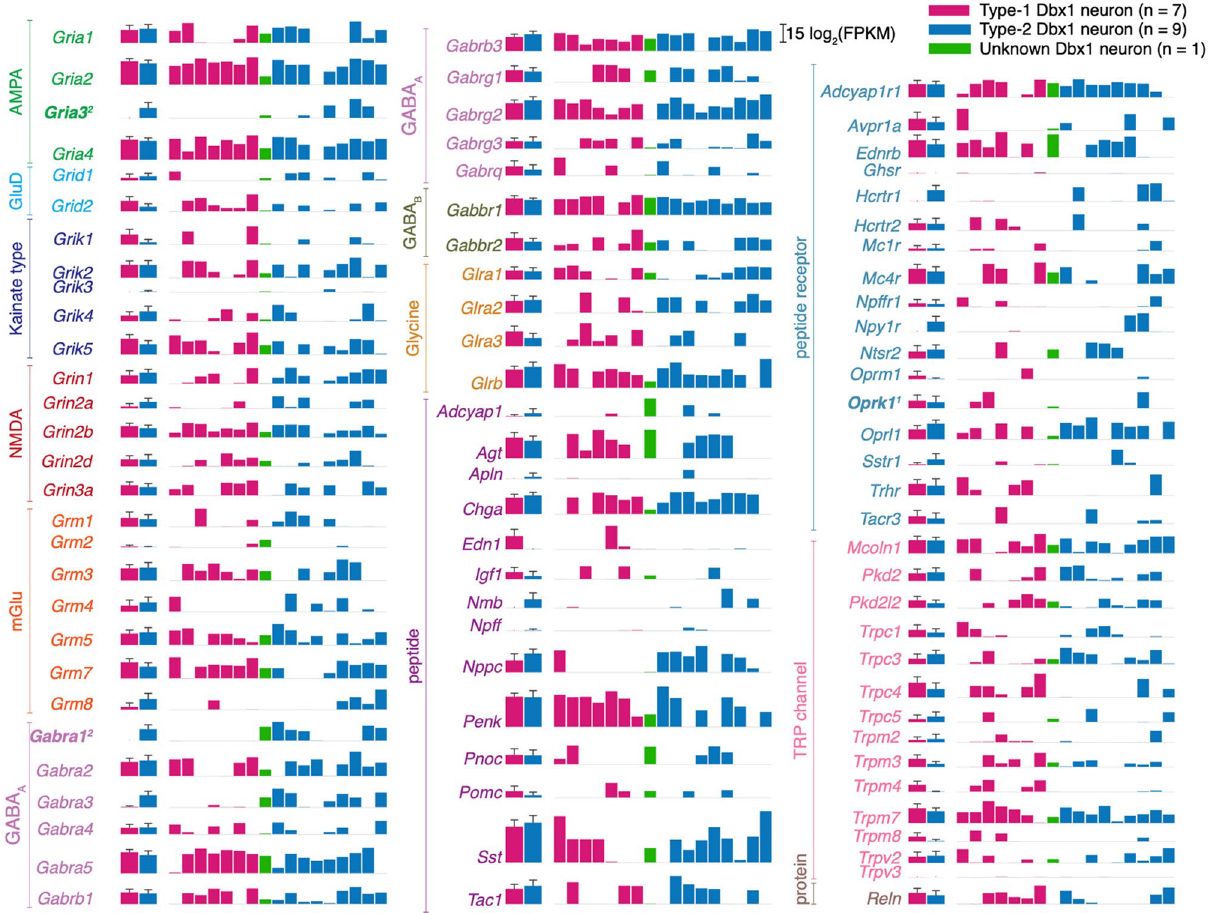
Figure 4. Quantitative gene expression for ionotropic and metabotropic synaptic receptors, neuropeptides, neuropeptide receptors, and Trp channels. The first two bars show group data for Type-1 (n = 7; magenta bar) and Type-2 (n = 9; blue-cyan bar). The height of the bar is log 2 (mean FPKM) value and the error bar with horizontal cap shows log 2 (mean + SD). The next set of 17 bars shows log 2 (FPKM) values for each neuron in the following order: 7 Type-1 neurons (magenta), 1 Unknown neuron (green), and 9 Type-2 neurons (blue-cyan). Gene names are color-coded according to the subfamily to which they belong. Gene names in bold indicate DE and contain a superscript 1 if upregulated Type-1 neurons and 2 if upregulated in Type-2 Synaptic inhibition influences inspiratory rhythm and output pattern 5,40–43 . We report upregulation of the GABA A receptor, Gabra1 , in Type-2 neurons; Gabra3 appears to be more highly expressed in Type-2 neurons but it did not pass the DESeq2 criteria for differential expression (Figs. 3 and 4, Supplementary Table 2). Of course GABAergic drive acts on Type-1 neurons, but Gabra1 (and perhaps Gabra3 ) upregulation in Type-2 neurons suggests that a stronger source of inhibitory drive may be equipped to bypass the oscillator (i.e., the predominant rhythmogenic Type-1 neuron class) and selectively act on the output pattern-generating Type-2 subpopulation to arrest inspiration with immediacy. Behavioral exigencies that might apply include the breath-hold dive reflex upon submersion; attentive immobility, that is, the arrest of all movement (including breathing) for predators stalking prey or prey attempting to camouflage themselves in the context of being hunted; or, finally, in the context of a Valsalva maneuver. Transcription factors program cell fate during embryonic development and regulate gene expression post- natally. This study was performed postnatally (P0-2) so one does not expect pre-mitotic transcription factors. Nevertheless, we detected genes that help differentiate cardinal cell populations in the ventral progenitor zone of the neural tube including Dbx2 , a sonic hedgehog-repressed (Class I) transcription factor co-expressed with Dbx1 in the p0 domain, and, surprisingly, a host of sonic hedgehog-induced (Class II) Nkx genes associated with more ventral domains (Supplementary Fig. 4). Because all 17 of our neurons were derived from Dbx1 -expressing precursors and 8 of 17 expressed Evx1 or Evx2 (Supplementary Fig. 4, Supplementary Table 3), and only 1 of 17 expressed Pax7, our sample represents the V0 ventral (V0 V ) cardinal class 44,45 . Further, we report upregulation of transcription factors Akna and Runx1 in Type-2 neurons (Fig. 3, Supple- mentary Table 2). Runx1 helps consolidate spinal motor neuron identity by suppressing interneuron programs 46 . It may, therefore, seem counterintuitive that Runx1 is upregulated in Type-2, but we speculate that it may be